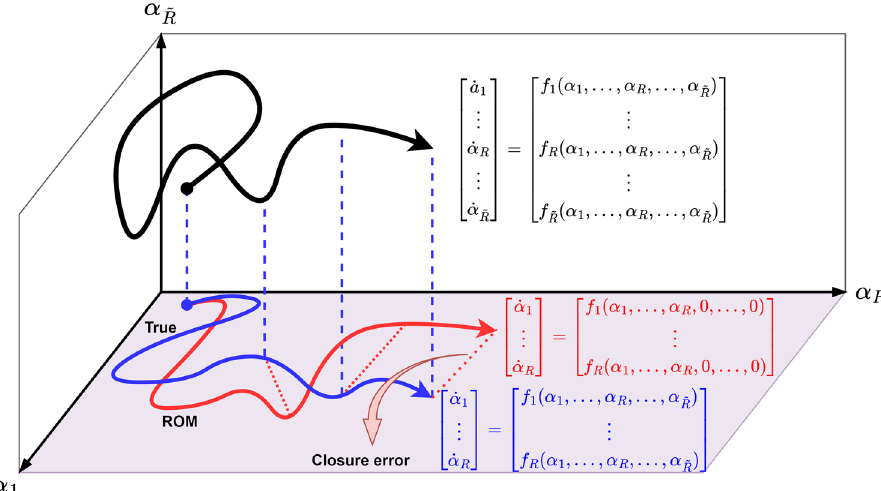
Figure 2. A schematic overview of the closure modeling in a hypothetical three-dimensional latent space. When we truncate a model spanned in a higher dimensional state space (i.e., dimensional model spanned in α 1 , α 2 , α 3 ) to a lower dimensional latent space (i.e., R = 2 in the figure, a reduced order two-dimensional model spanned only in α 1 , α 2 ), a closure error will be introduced due to the underlying nonlinear interactions. The main goal in closure modeling is to find a parameterized model, which is only function of resolved modal coefficients (i.e., α 1 , . . . , α R ) to minimize this closure error. Therefore, in this paper we formulate an RL problem to discover this closure model using the state variables (i.e., resolved modal